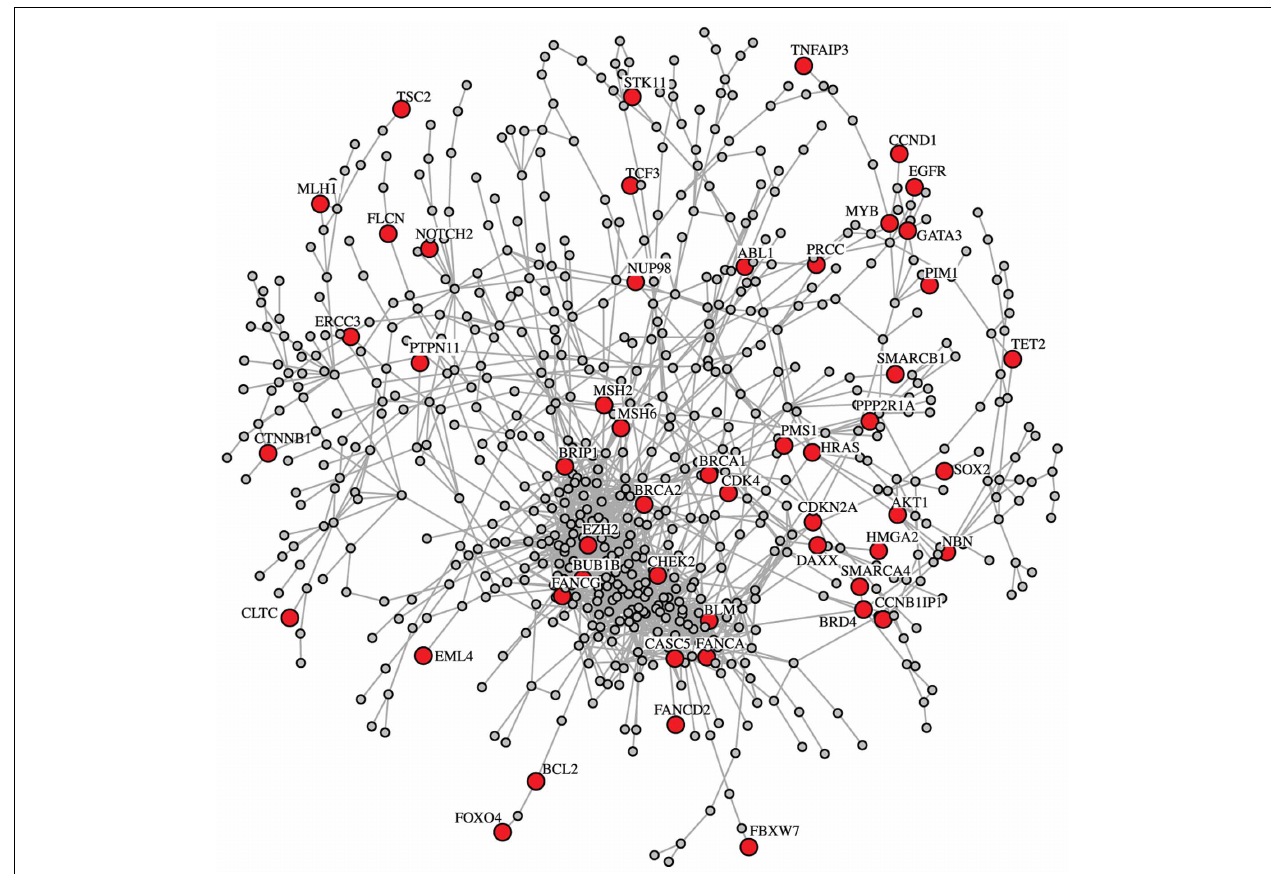
FIGURE 1 | Subnetwork of the breast cancer GRN for the biological process cell cycle (GO:0007049). This subnetwork includes 51 census cancer genes, e.g., BRCA1 and BRCA2 . The census cancer genes are highlighted in red. Overall, the shown network consists of 728 genes and 1671 interactions.